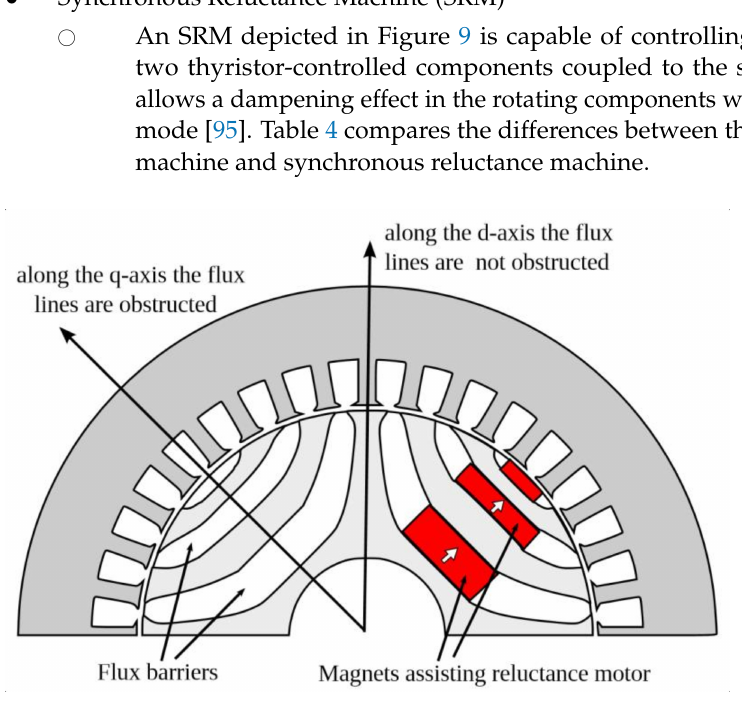
Figure 9. Diagram of a synchronous reluctance motor, adapted from [95]. Table 4. Comparison between switched reluctance machine and synchronous reluctance machine. Switched Reluctance Machine Synchronous Reluctance Machine